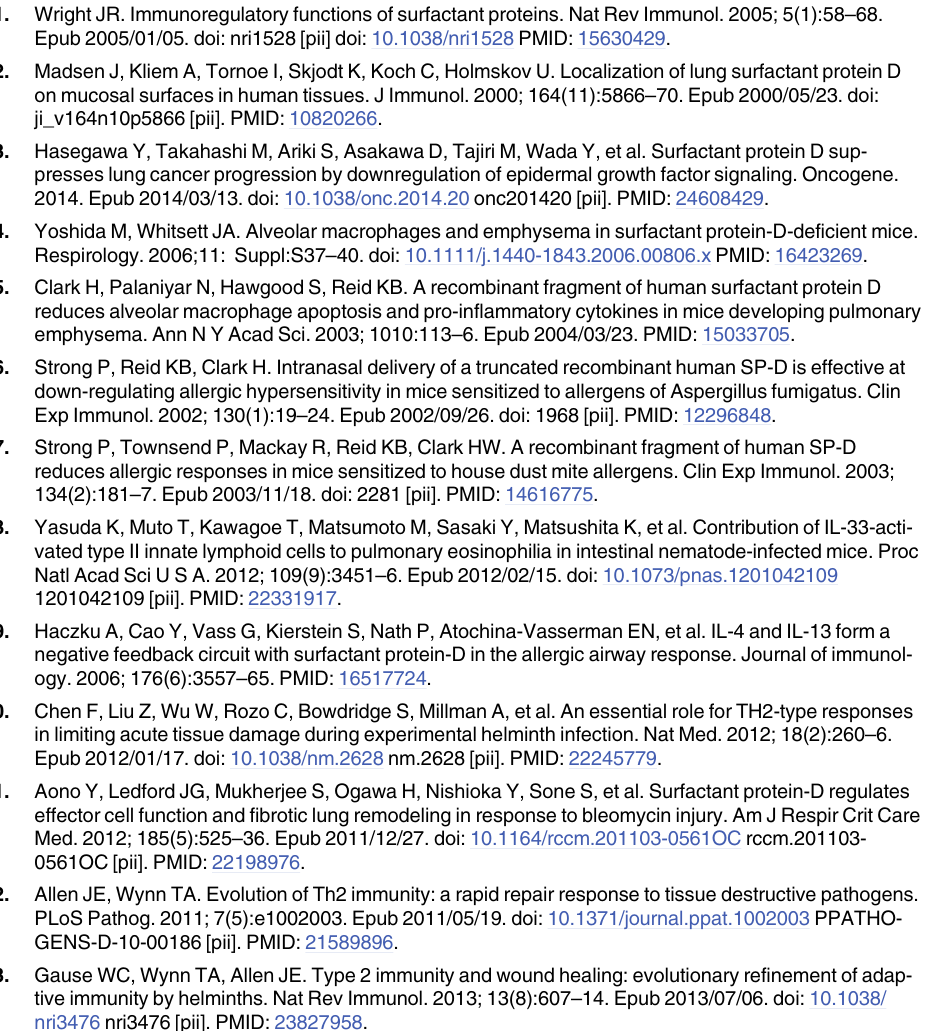
S5 Fig. Morphology and immune characterization of adoptively transferred alveolar mac- rophage populations. Light microscope analysis of macrophage morphology in cells isolated from N . brasiliensis infected and N . brasiliensis + SP-D treated mice ( a ). Expression levels of YM1 and RELM- α on alveolar macrophages isolated from N . brasiliensis infected and N . brasi- liensis infected + SP-D treated mice ( b ). Data are representative of 2 individual experiments.